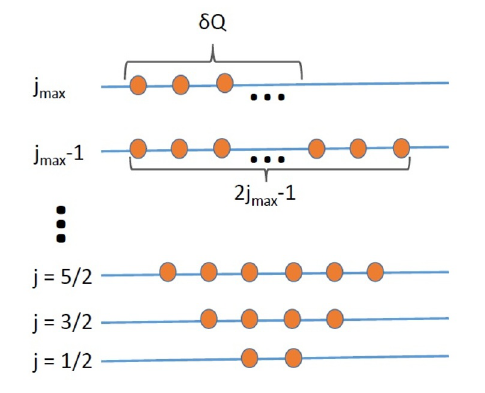
Figure 1. An illustration describing the energy shells. For each j < j max , there are 2 j + 1 occupied states in each shell. At the outermost shell, which corresponds to the j δQ occupied states, where 0 ≤ δQ ≤ 2 j max + 1 . For δQ = 0 or δQ = 2 j max + 1 , the outermost shell is filled and we recover the homogenous and isotropic ground state with an associated ∆ given by equation